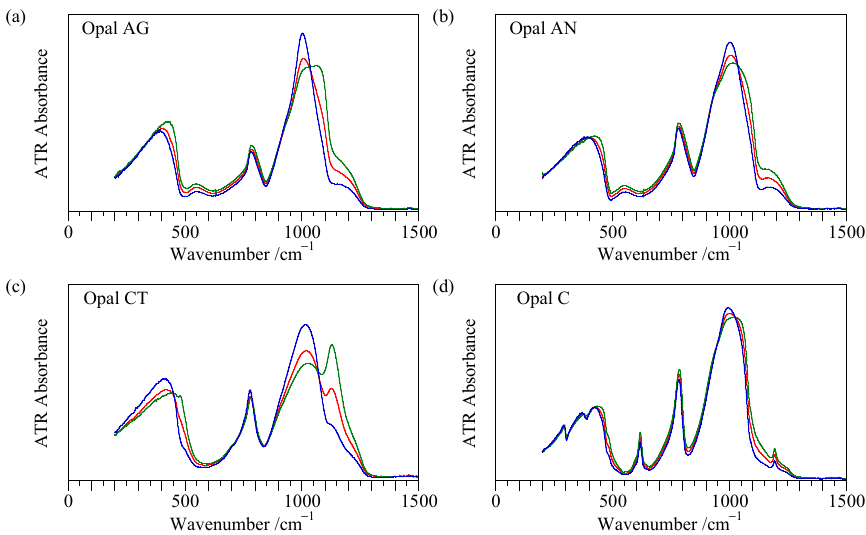
Figure 13. Flat sample ATR measurements (Bruker v80 instrument) of polished thin slice showing the effect of polarisation ( a ) opal-AG (CP-2 from Coober Pedy, South Australia, Australia, ( b ) opal-AN (MS-1 from Mount Squaretop, Queensland, Australia, ( c ) opal-CT (G9942 from Angaston, South Australia, Australia) and ( d ) opal-C (T1664 from Guanajuanto, Mexico). Red is unpolarised, green is p -polarised and blue is s -polarised. IR spectra are corrected for ATR depth penetration but not otherwise manipulated.